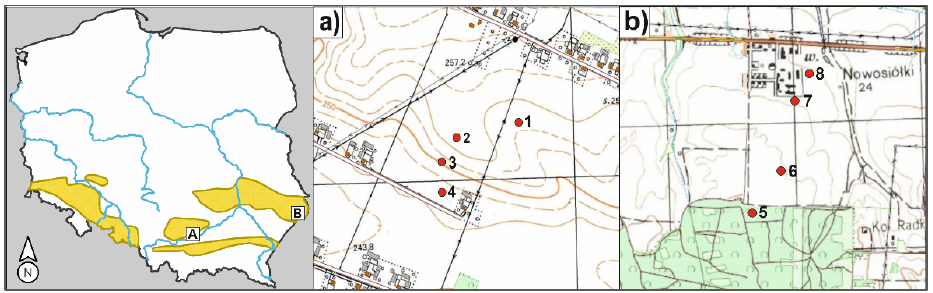
Figure 1. Localization of sampling areas in ( A ) and ( a ) Proszowice Plateau (catena 1: profiles 1–4), ( B ) and ( b ) Hrubieszów Basin (catena 2: profiles 5–8).